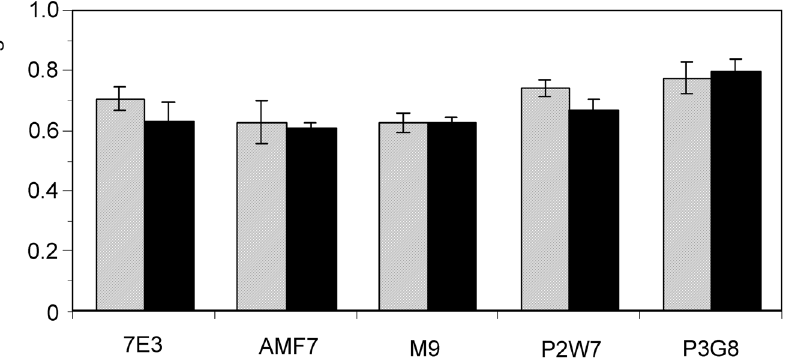
Figure 7. Effect of integrin extension on the binding of the anti- a V b 3 mAbs. Wild-type a V or a V carrying the Q589NAT mutation was transiently expressed together with wild-type b 3 in CHO cells. The binding of function-blocking mAbs to these cells was examined by FACS. The MFI obtained from the whole cell population with each mAb was normalized by the MFI obtained with an anti- a V mAb 17E6 that represents the a V expression. There was no significant difference in the binding of leg-binding mAbs in cells expressing Q589NAT (solid column) as compared with cells expressing wild-type a V (hatched column).